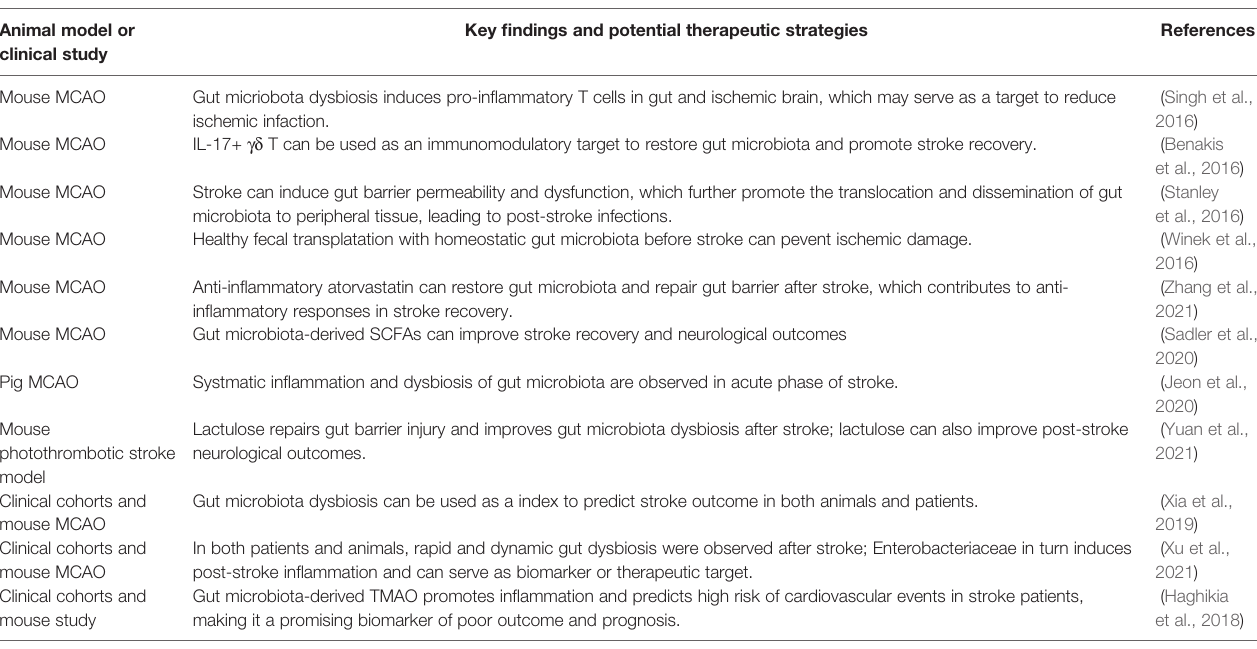
TABLE 1 | Evidences of the correlation between gut microbiota and ischemic